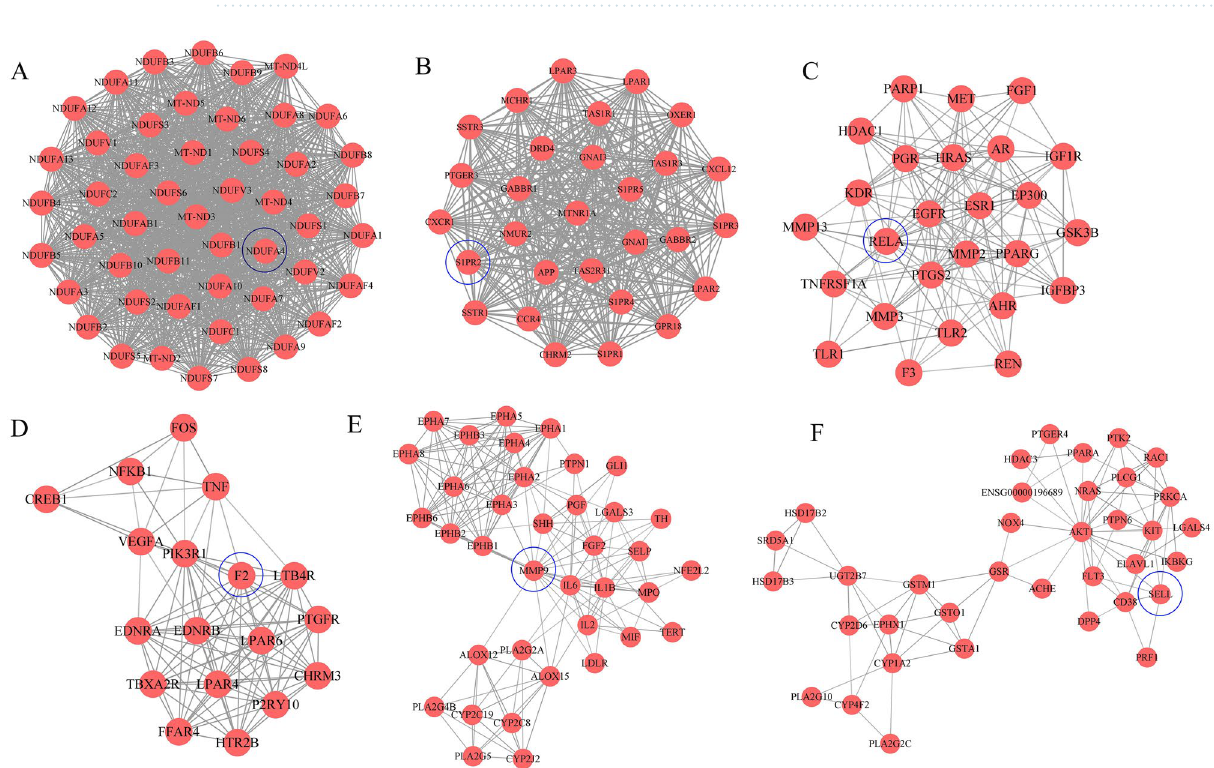
Figure 3. Clusters of compound predicted targets PPI network. ( A – F ) are clusters we found in the predicted targets PPI network which stands for cluster 1 to 6, respectively. The seed node of each clusters is marked with blue